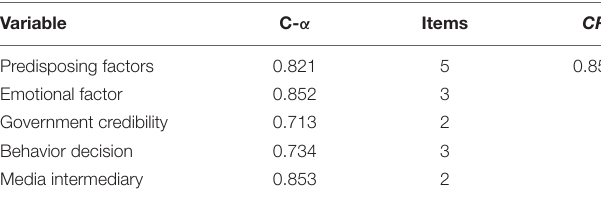
TABLE 2 | Cronbach’s reliability coefficient table for each